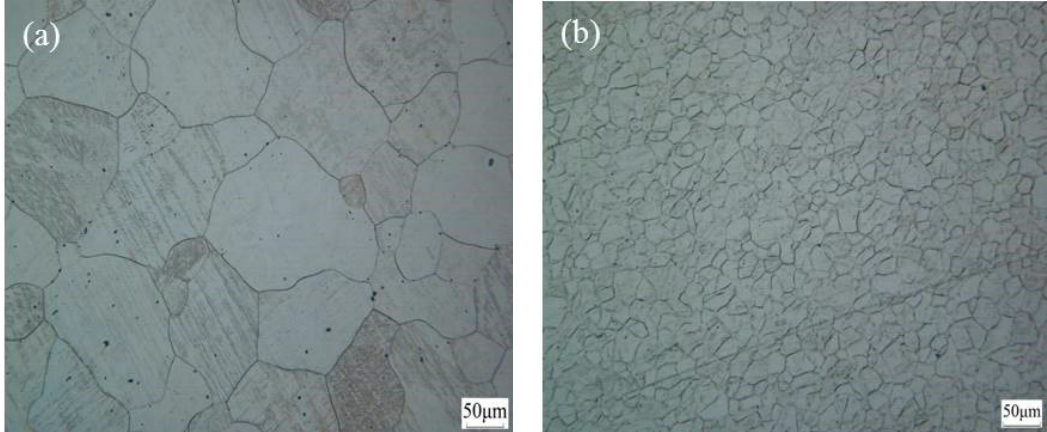
Figure 4. Optical microstructures of the Mg-2Y-0.6Nd-0.6Zr magnesium alloy: ( a ) As-cast state, and ( b ) as-rolled state.